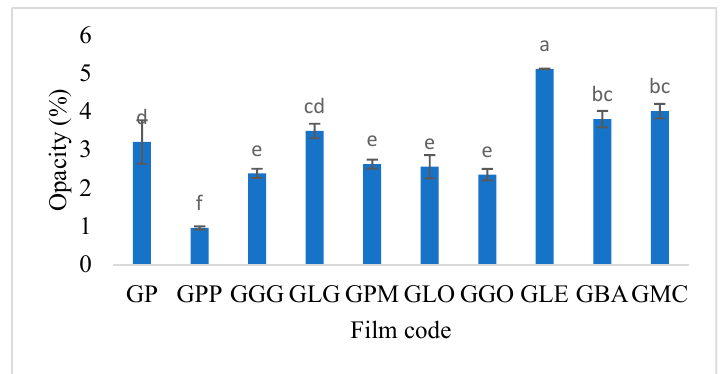
Figure 3. Opacity of studied edible films incorporating essential oils and plant extracts. Data are means ± standard deviations. Data of each column not sharing similar letters are significantly different at p < 0.05.